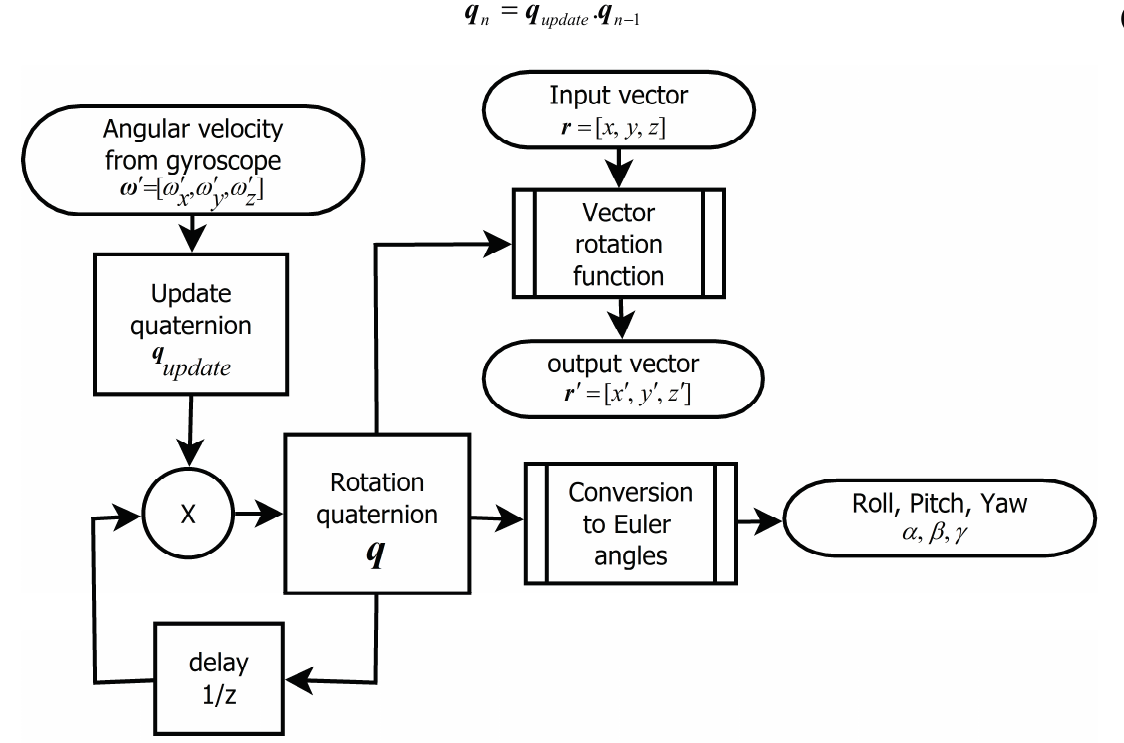
Figure 11. Principle of the quaternion-based